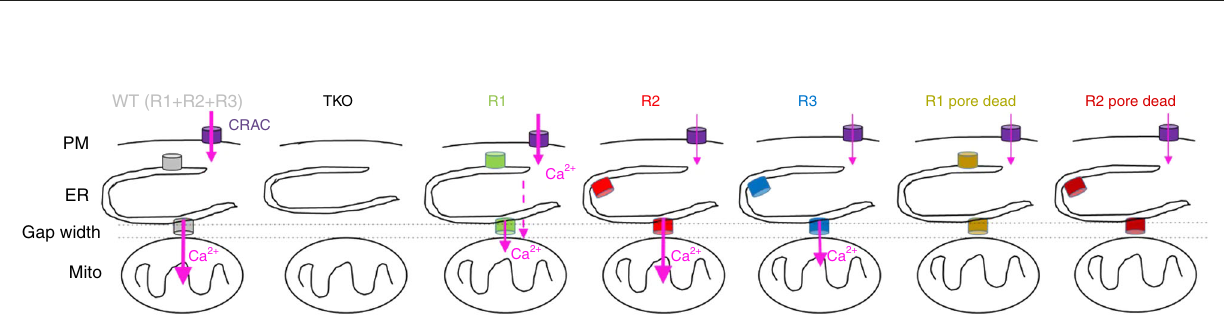
Fig. 7 Scheme of the structural and functional properties of the individual IP3R isoforms in supporting the ER-mitochondrial interface and mitochondrial Ca 2 +